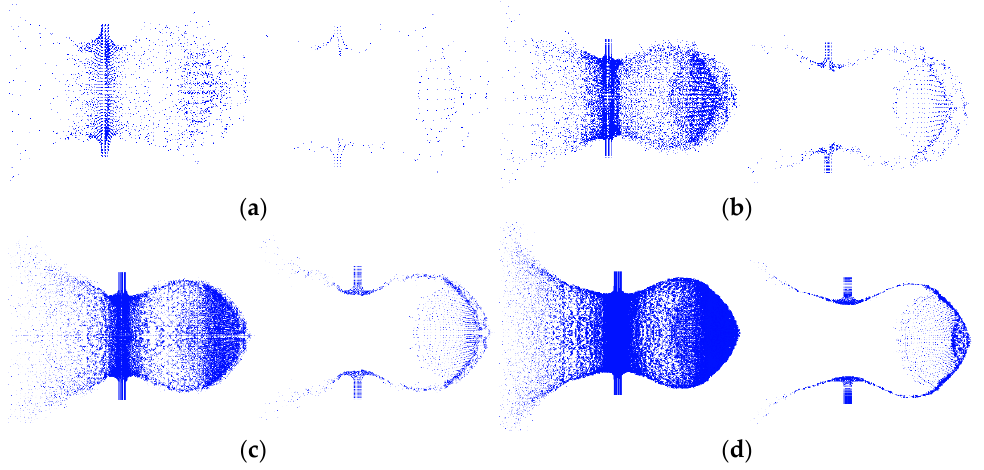
Figure 7. Contours and section graphs of debris cloud under different particle sizes. ( a ) Particle size 0.8 mm; ( b ) particle size 0.4 mm; ( c ) particle size 0.2 mm; ( d ) particle size 0.1 mm.